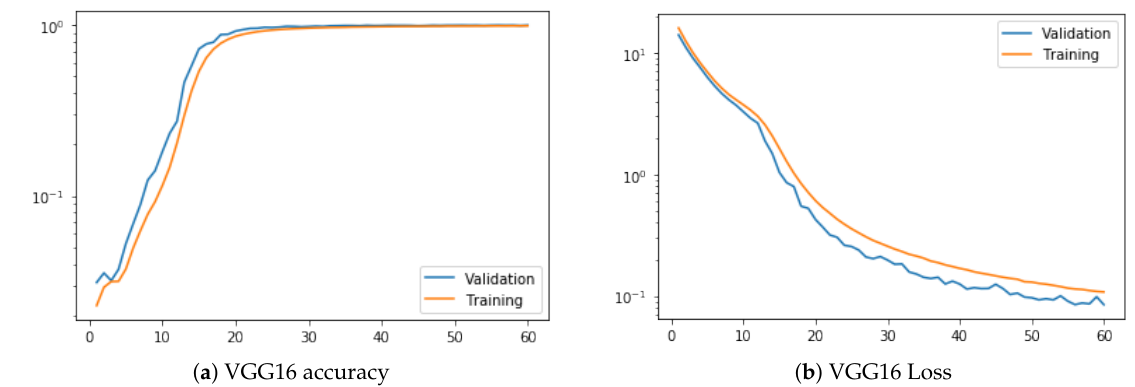
Figure A3. Performance of the loss and accuracy metrics of the training (orange) and validation (blue) data during the training of the VGG16 model. The values of the metrics are suitable, however in the main text we have seen that the model does not generalize to experimental images, which indicates that loss and accuracy metrics during training often cannot be taken as the only method of evaluating a